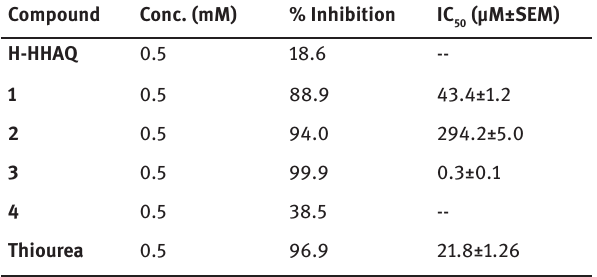
Table 4: Urease Inhibition by metal complexes of H-HHAQ.